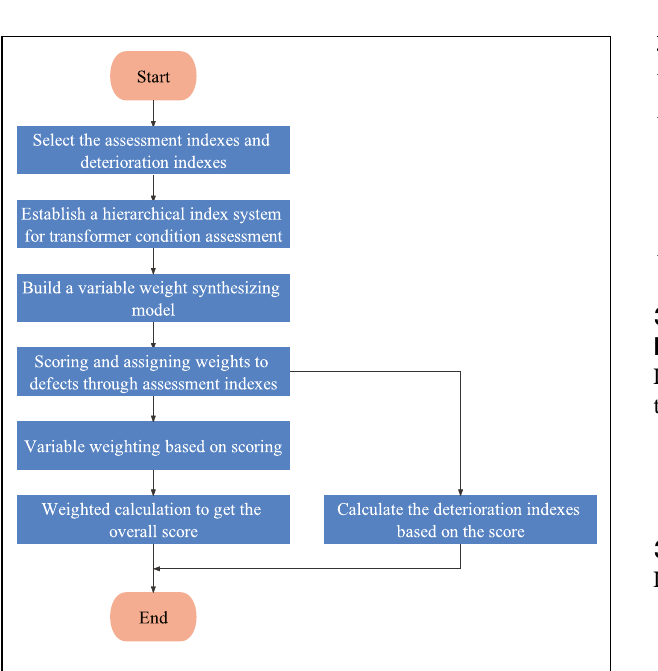
FIGURE 2 | Flowchart of transformer condition